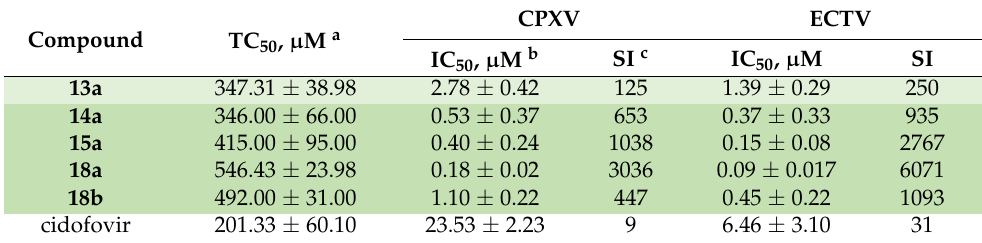
Table 2. Antipox activity of 13a – 15a, 18a , b against CPXV and ECTV.